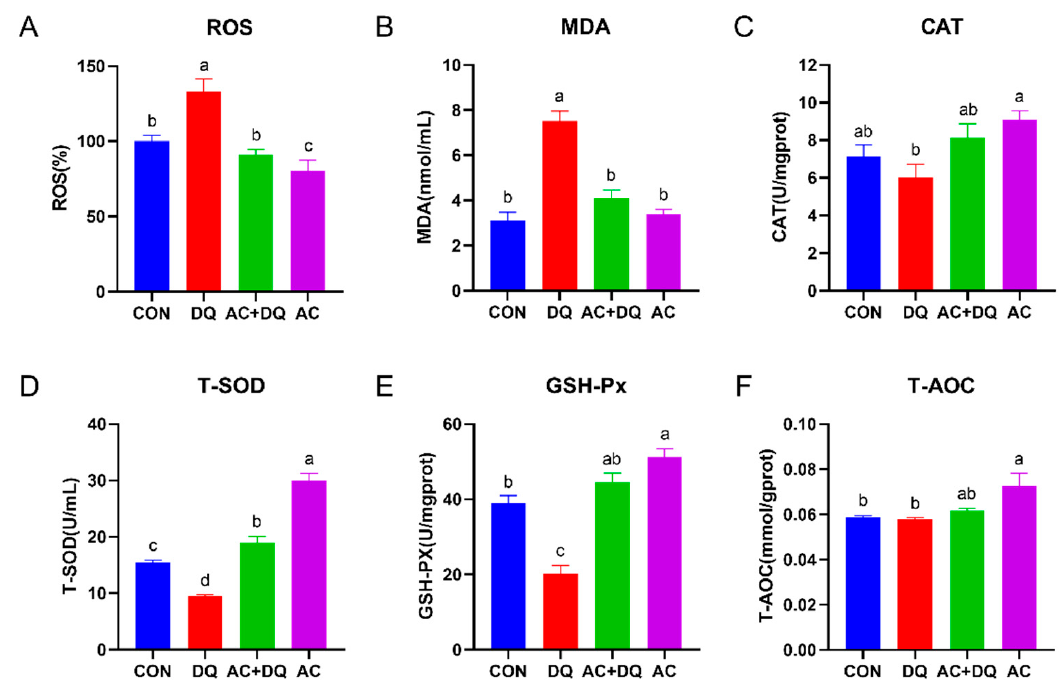
Figure 2. Acidifiers alleviated oxidative stress induced by diquat in IPEC-J2 cells and improved antioxidant capacity. ( A ) Intracellular contents of oxygen reactive species (ROS). ( B ) Cellular MDA levels. ( C ) Cellular CAT activity. ( D ) Cellular T-SOD activity. ( E ) Cellular GSH-Px activity. ( F ) Cellular T-AOC levels. CON, cells without being treated; DQ, cells were only treated by 1150 µ M of diquat for 6 h; AC + DQ, cells were pretreated by 0.005% acidifier for 4 h and were then treated by 1150 µ M of diquat for 6 h. AC, cells were only treated by 1150 µ M of acidifier for 4 h. All values were represented as means ± SEM ( n = 6). Different superscript letters denote a statistically significant difference between groups ( p < 0.05), while same letters denote no significant difference.